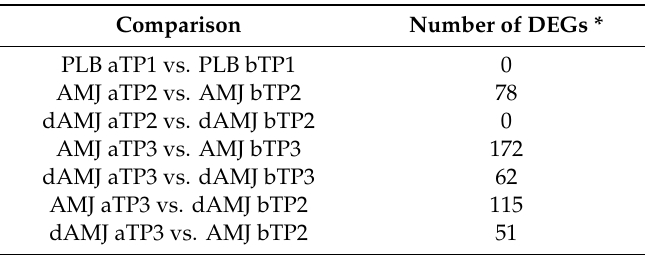
Table 1. The number of di ff erentially expressed genes in peripheral blood mononuclear cells of the study subjects, identified in di ff erent treatment